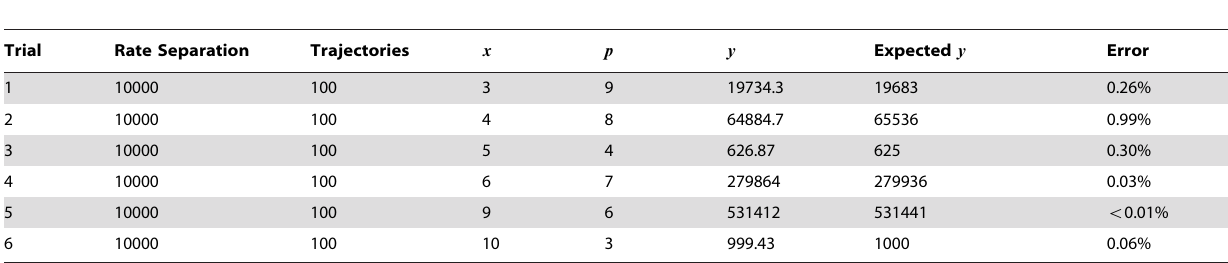
Table 4. Statistical Simulation Results from ‘‘Raise to a Power’’ Construct.